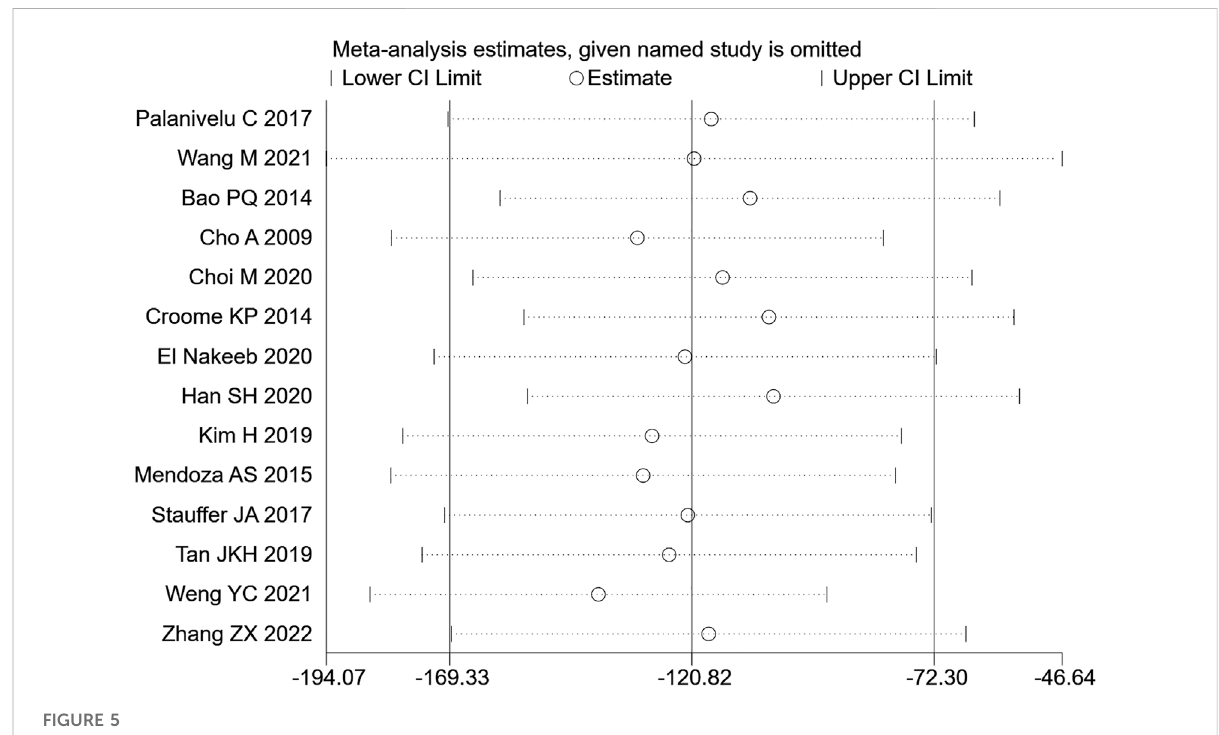
FIGURE 5 Sensitivity analysis of intraoperative blood